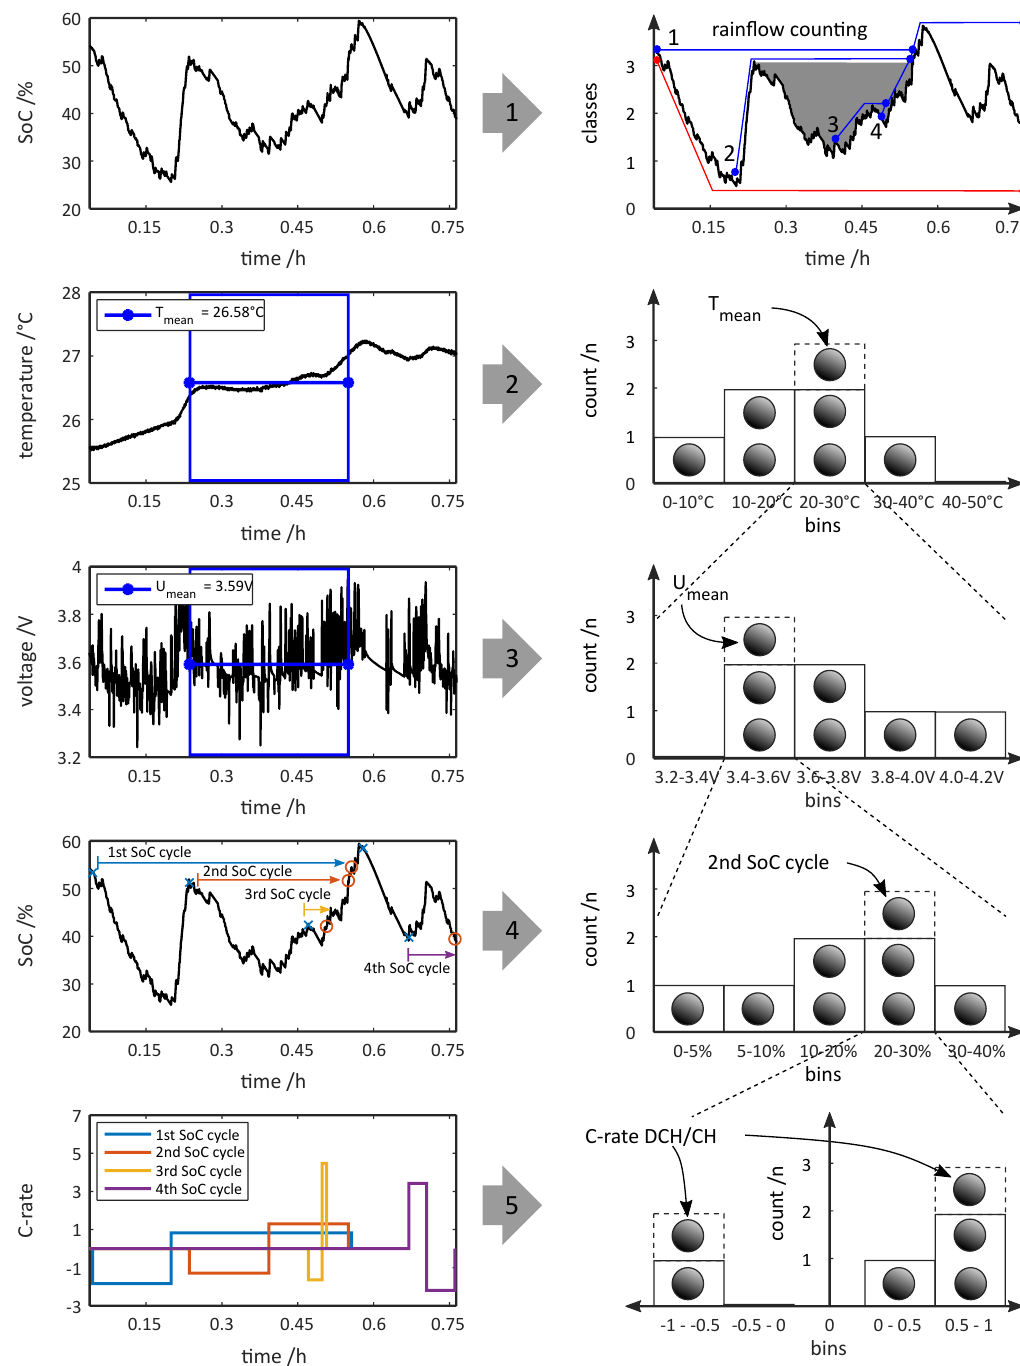
Figure 6. Construction procedure of “Nested” load collectives for battery data